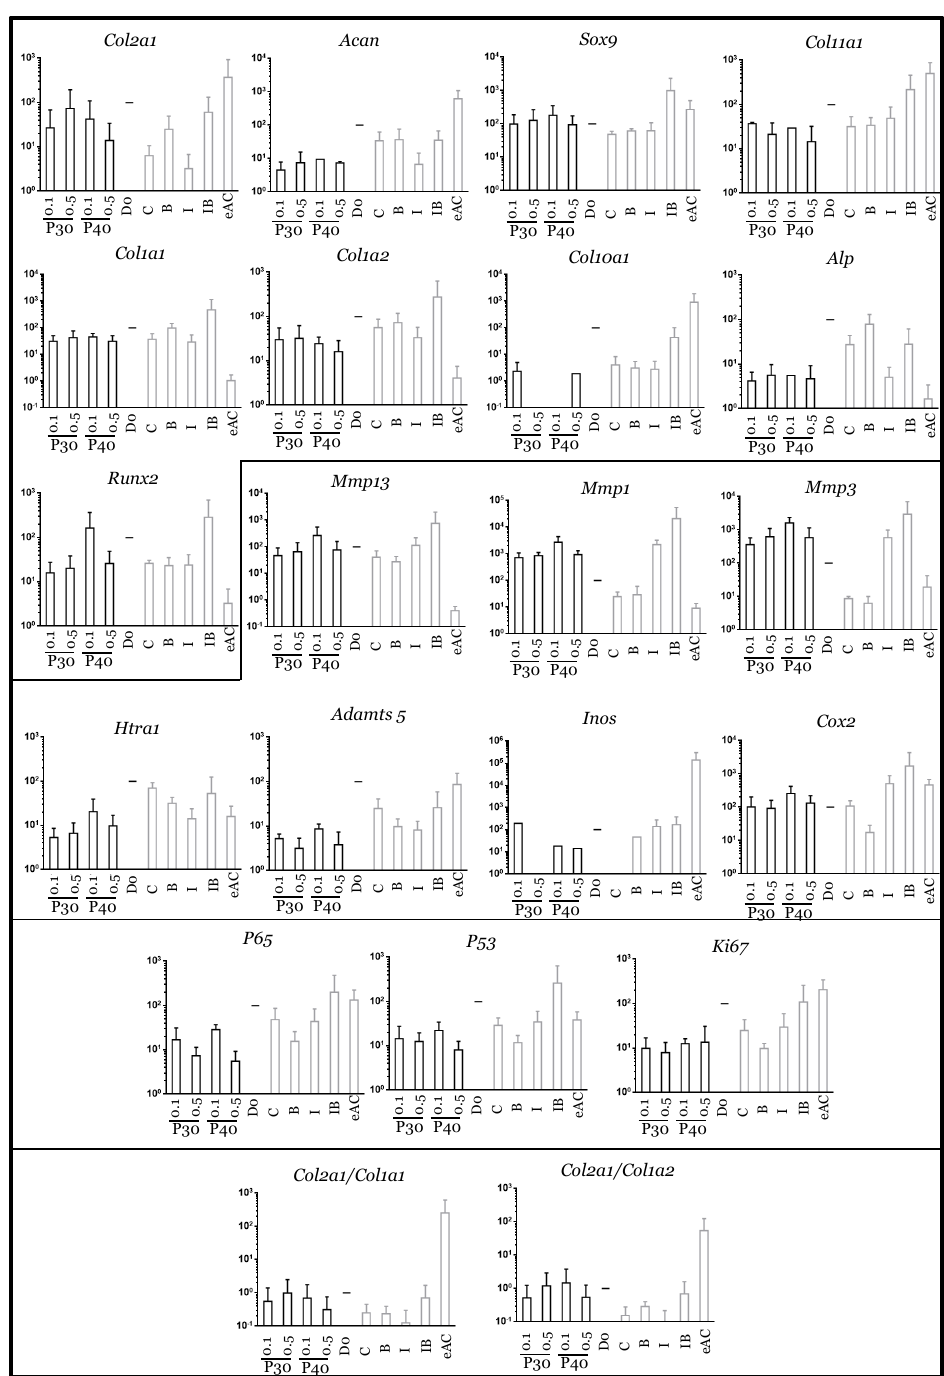
Figure 12. mRNA expression in equine articular chondrocytes treated with low concentrations of Promerim ® 30 and 40 in the presence of both IL-1 and BMP-2. Equine articular chondrocytes were grown in type I/III collagen sponges at the third passage (P3). They were incubated for 7 days under hypoxia in the absence (C: control) or both the presence of P30 + IL-1 + BMP-2 and P40 + IL-1 + BMP-2, or BMP-2 alone (B), or IL-1 alone (I), or BMP-2 together with IL-1 (IB). The Promerim ® were used at the concentrations of 0.1 and 0.5 µg/mL. The mRNAs were estimated using RT-qPCR after normalization with respect to the β -actin reference gene. Transcript expression is shown in arbitrary units. The Col2a1 : Col1a1 and Col2a1 : Col1a2 ratios are given. The results are shown as histograms and the significance of the values between the different treatments and the control case (IL-1 + BMP-2) was tested using a Mann–Whitney test; n = 3. eAC: mRNA extracts obtained from equine articular chondrocytes released from cartilage after overnight enzymatic digestion were used as controls. D0: cells seeded in sponges and arrested after 16 h of incubation. P30 and P40: Promerim ® 30 and